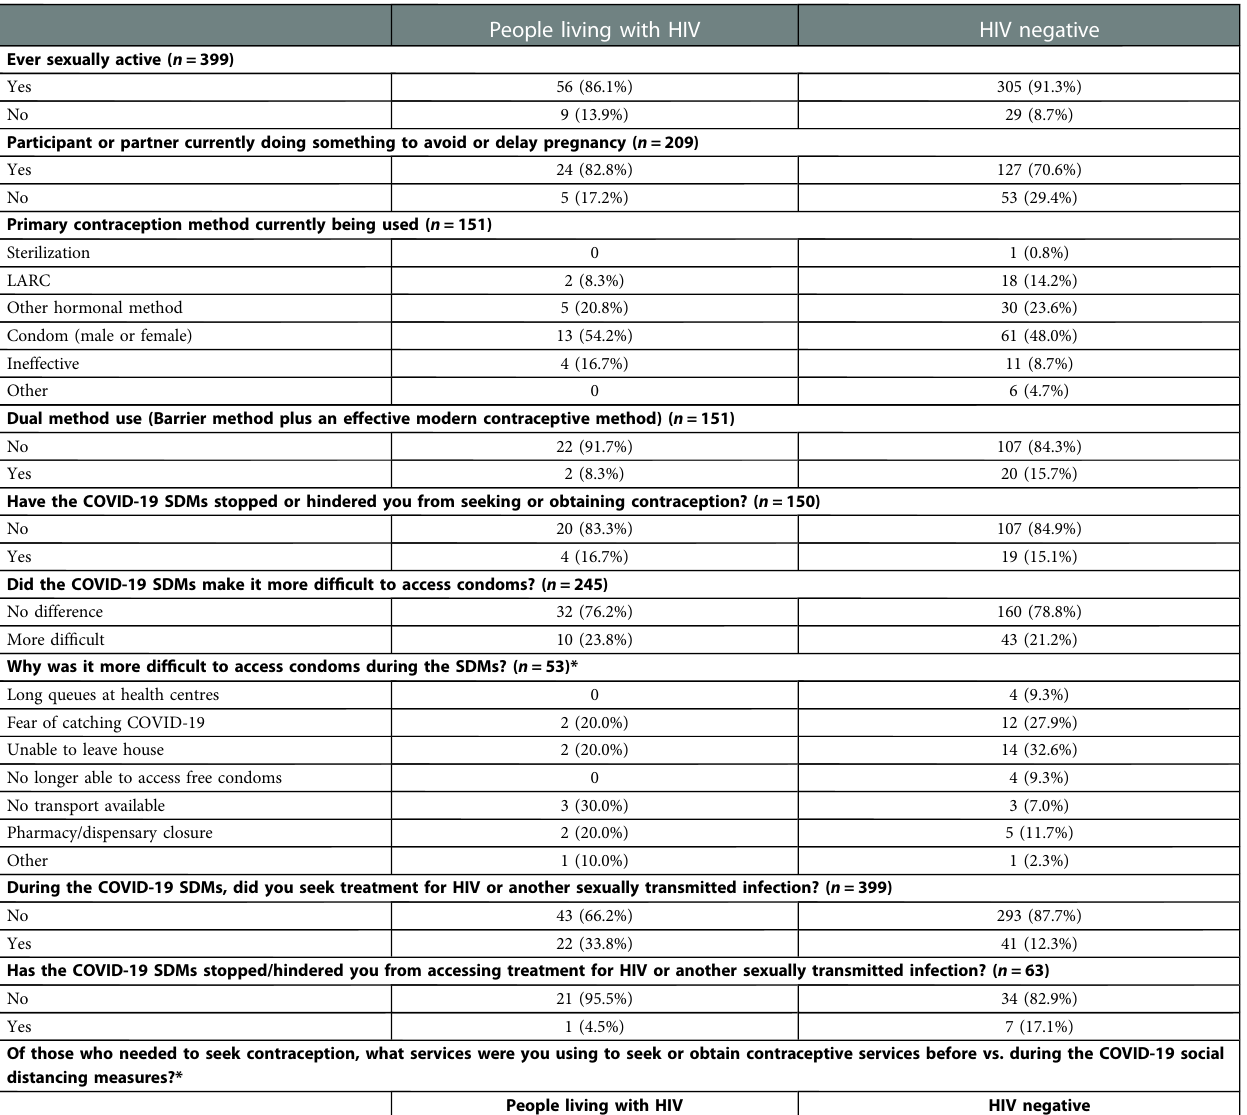
TABLE 2 Comparative use and patterns of access to essential sexual health services before and during social distancing measures by HIV status, for respondents of the Botswana I-SHARE study. People living with HIV HIV negative Ever sexually active ( n =399) 56